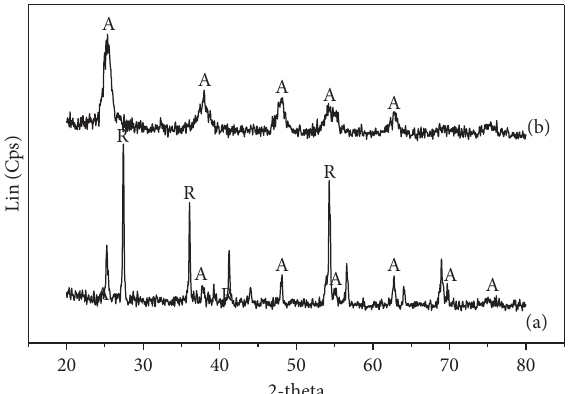
Figure 1: XRD patterns of TiO